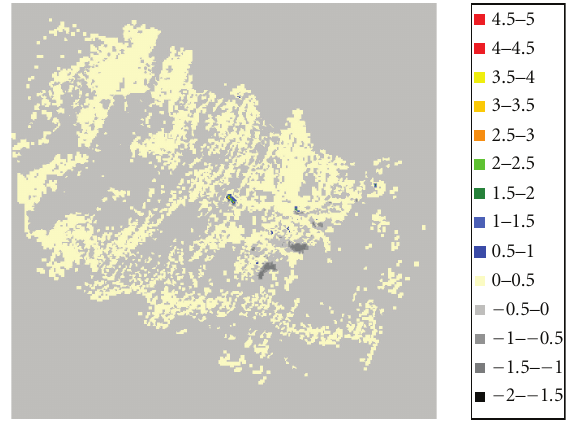
Figure 8: Plot showing the di ff erence between the two cost maps, simulated cost-real cost, at each ( x , y ) point in the scene. The major disparity between the two cost maps in the regions behind the vege- tation is clearly